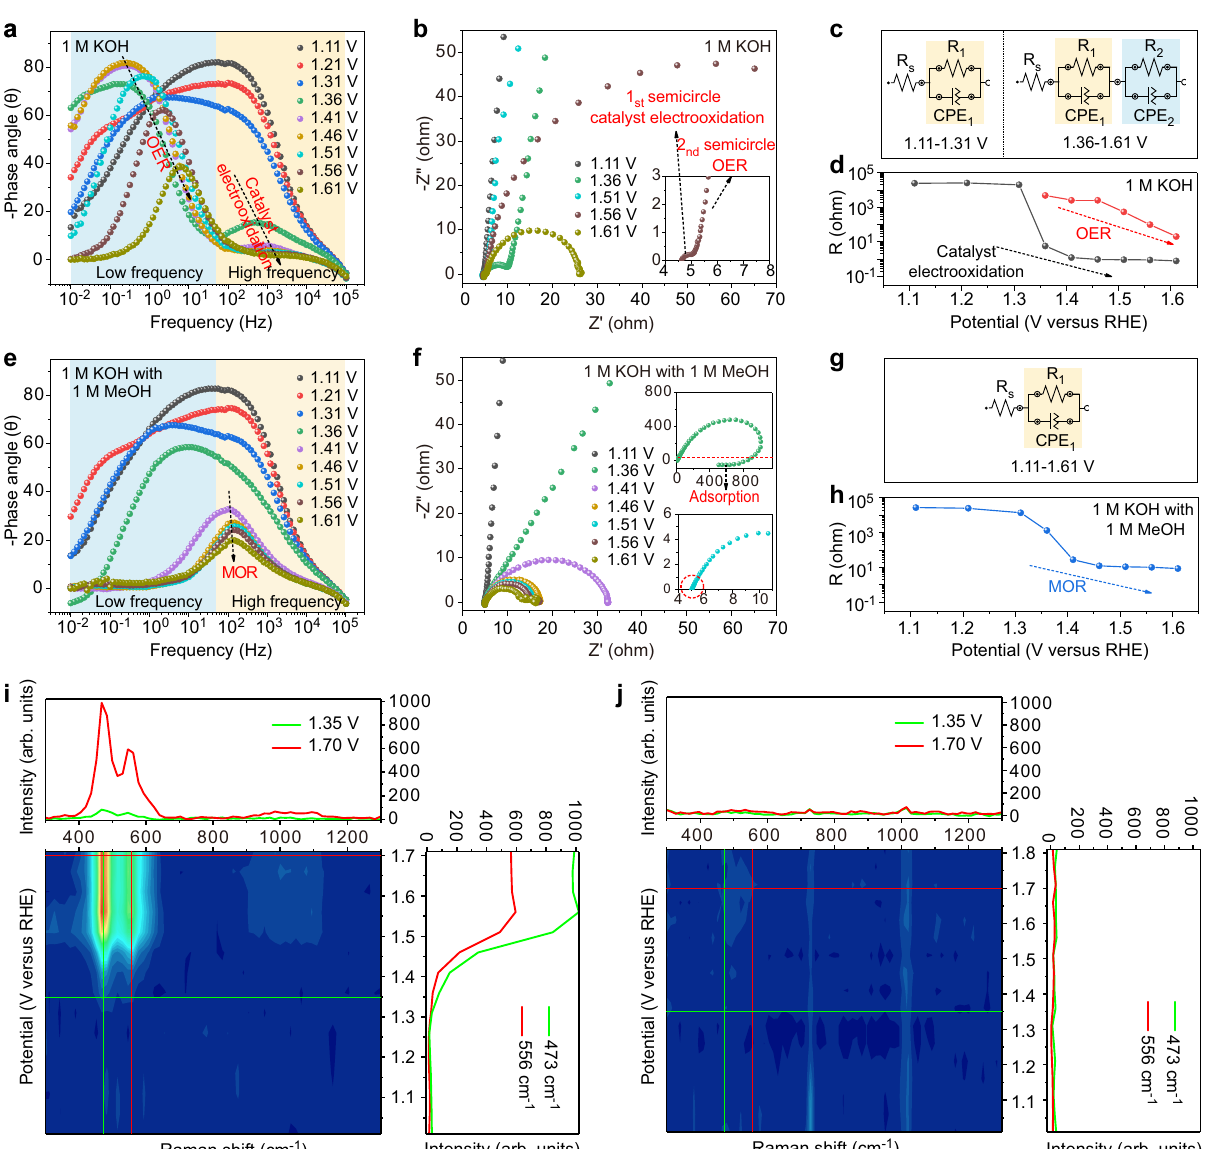
Fig. 3 | Operando electrochemical impedance spectroscopy characterization. a Bode plots and b Nyquist plots of NiB-400 for OER in different potentials. c Equivalent circuit models forOER. d Correlationof the equivalent resistances (R 1 andR 2 )andpotentialsforNiB-400duringOER. e Bodeplots. f NyquistplotsofNiB-